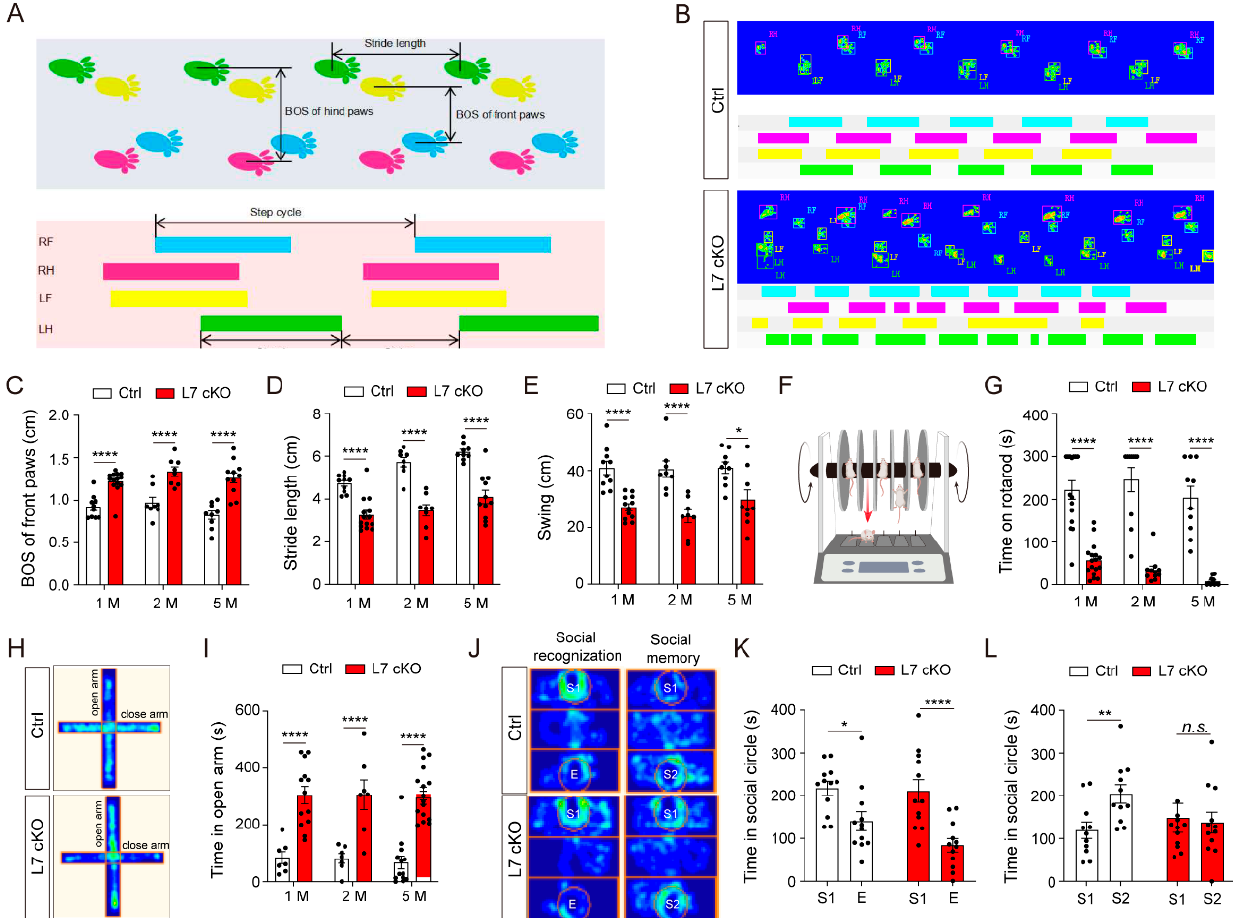
Figure 2. PC-speci fi c OGT null mice show impaired motor coordination and social memory. ( A , B ) Representative catwalk footprints of Ctrl and cKO mice. ( C , D ) Quanti fi cation of the length of BOS of the front and hind paws (mean ± SEM; **** p < 0.0001, n > 7). ( E ) Quanti fi cation of the swing time. Only the results for the right front paw (RF) are shown (mean ± SEM; * p < 0.05, **** p < 0.0001, n > 7). ( F , G ) Time spent on the accelerating rotarod by the Ctrl and cKO mice (mean ± SEM; **** p < 0.0001, n > 7). ( H ) Heat map representing the positions of the mice in the open fi eld. ( I ) Time spent in the open arms by the Ctrl and cKO mice (mean ± SEM; **** p < 0.0001, n > 7). ( J ) Heat map repre- senting the positions of the test mice. ( K , L ) Time spent in the social areas of the empty (E), stranger 1 (S1) or stranger 2 (S2) cages (mean ± SEM; * p < 0.05, ** p < 0.01, **** p < 0.0001, n.s. = no signi fi cance, n > 10). RF, right front paw; RH, right hind paw; LF, left front paw; LH, left hind paw.